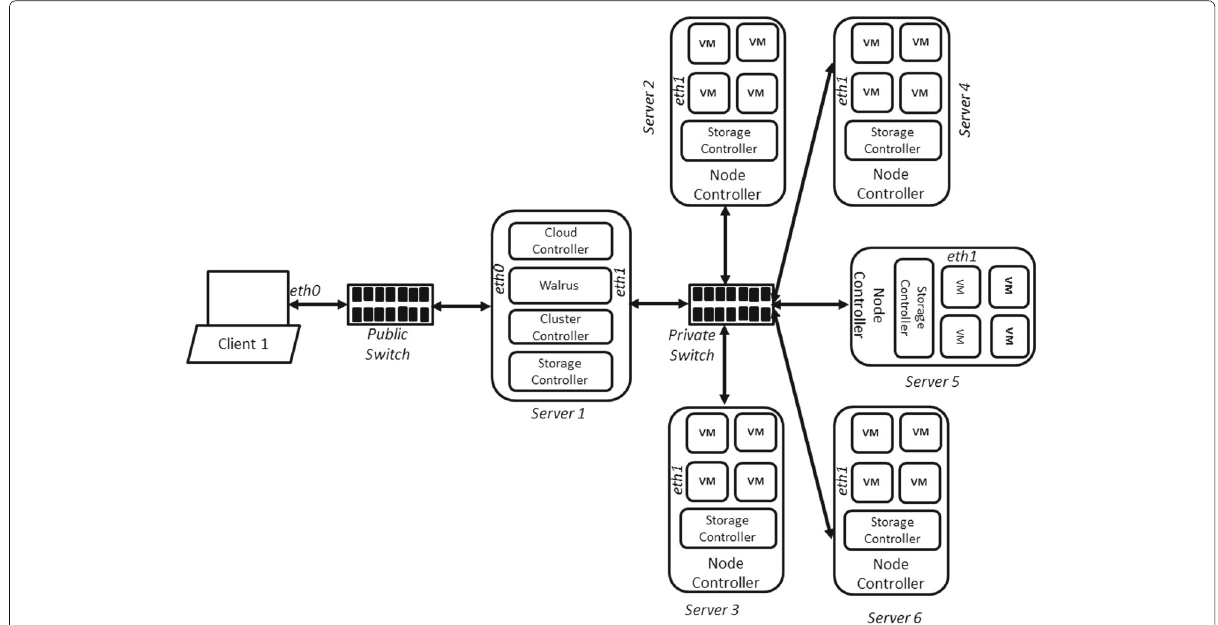
Fig. 5 Setup of the UEC used for